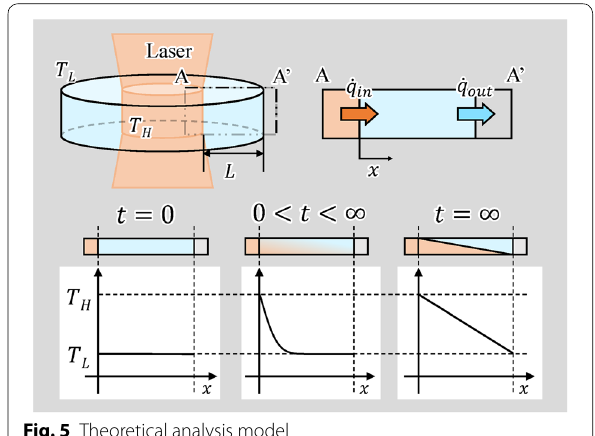
Fig. 5 Theoretical analysis